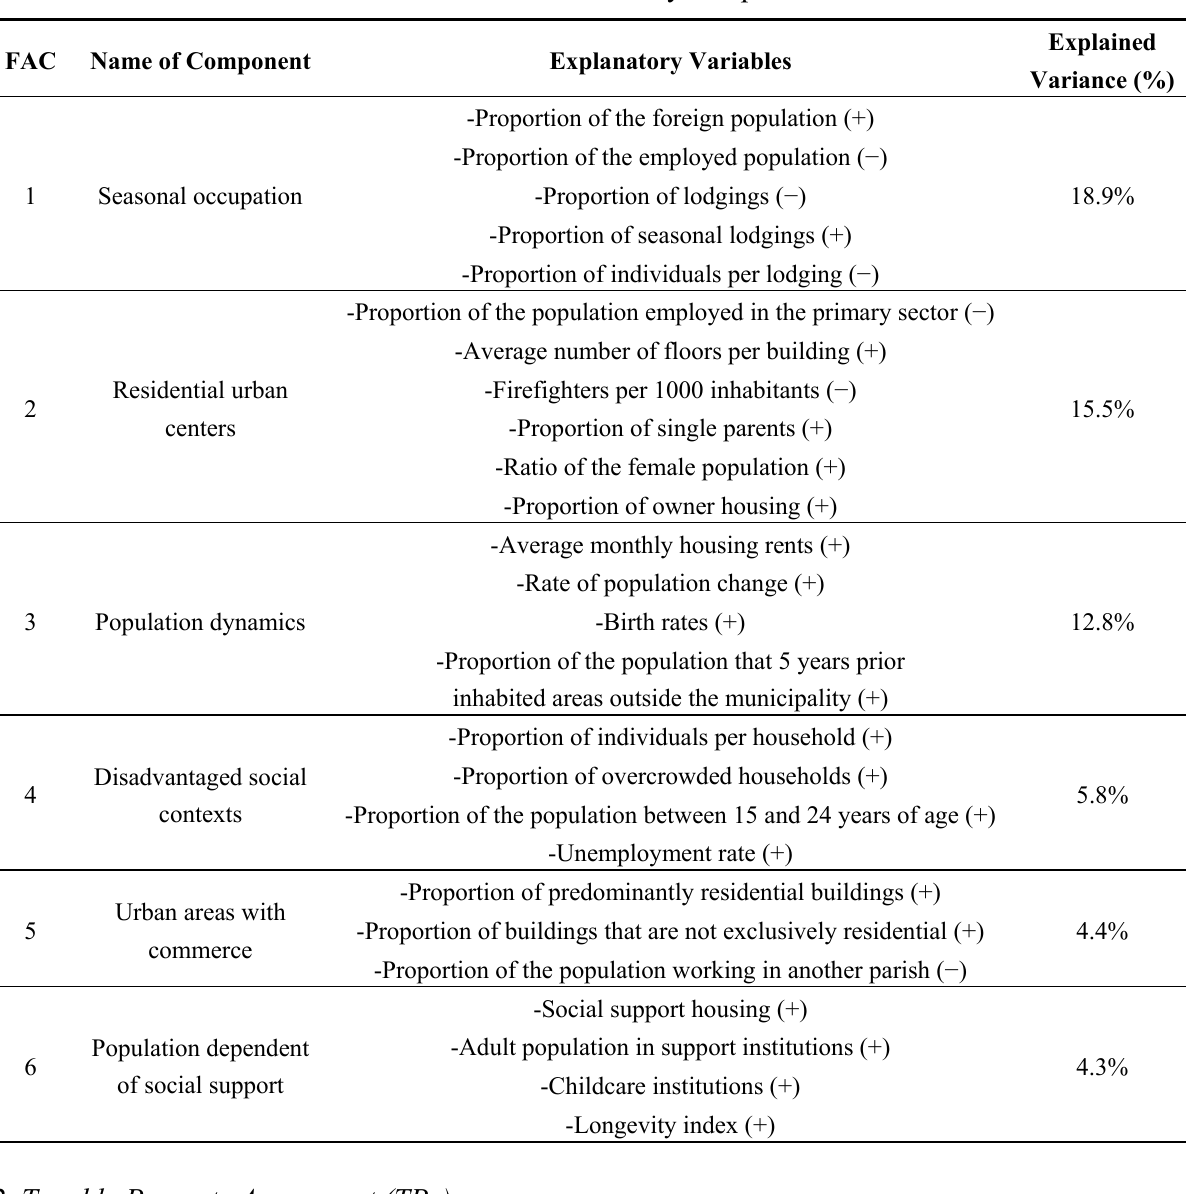
Table 2. Social vulnerability